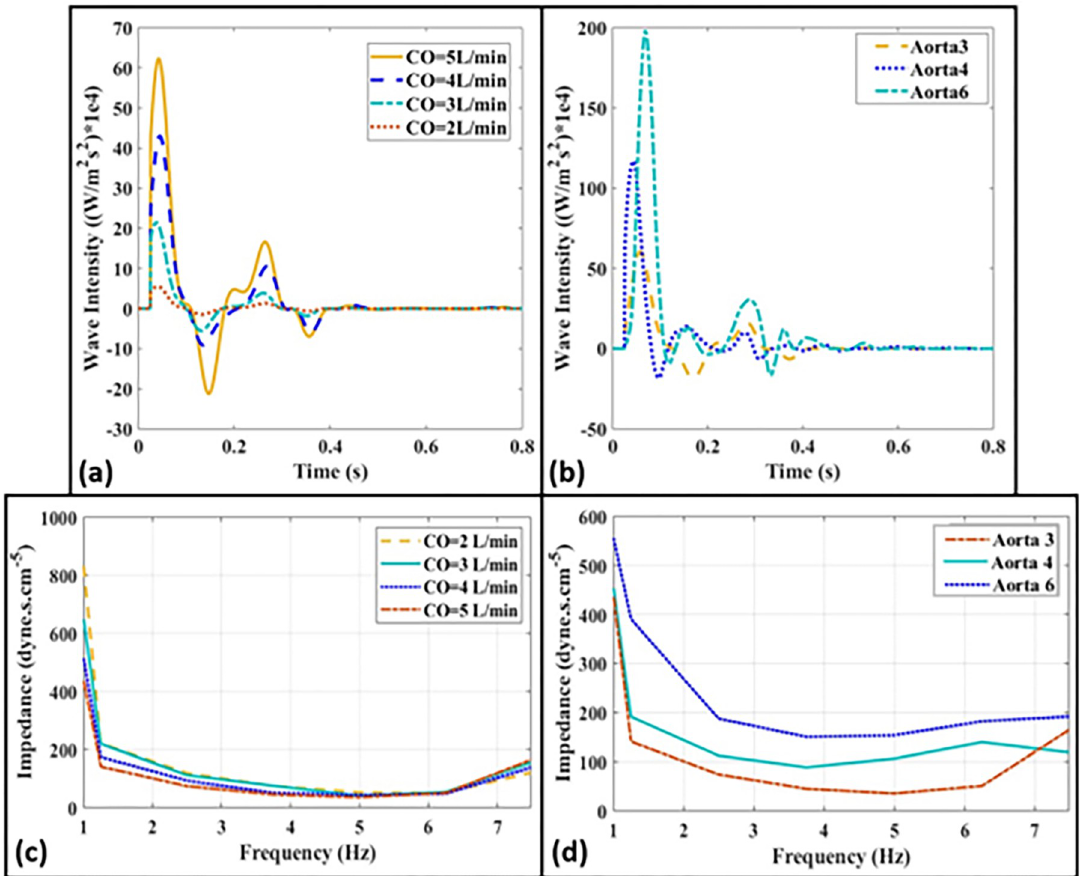
Fig 7. Wave intensity profiles measured at the ascending aorta for (a) different cardiac outputs of the same Aorta-3 ( CO = 2, 3, 4, 5 L/ min), (b) different aortas for the same CO = 5 L/min (Aorta-3, 4, 6). (c, d) Aortic input impedances corresponding to the same configurations of (a,b ). Heart rate is 75 bpm for all the